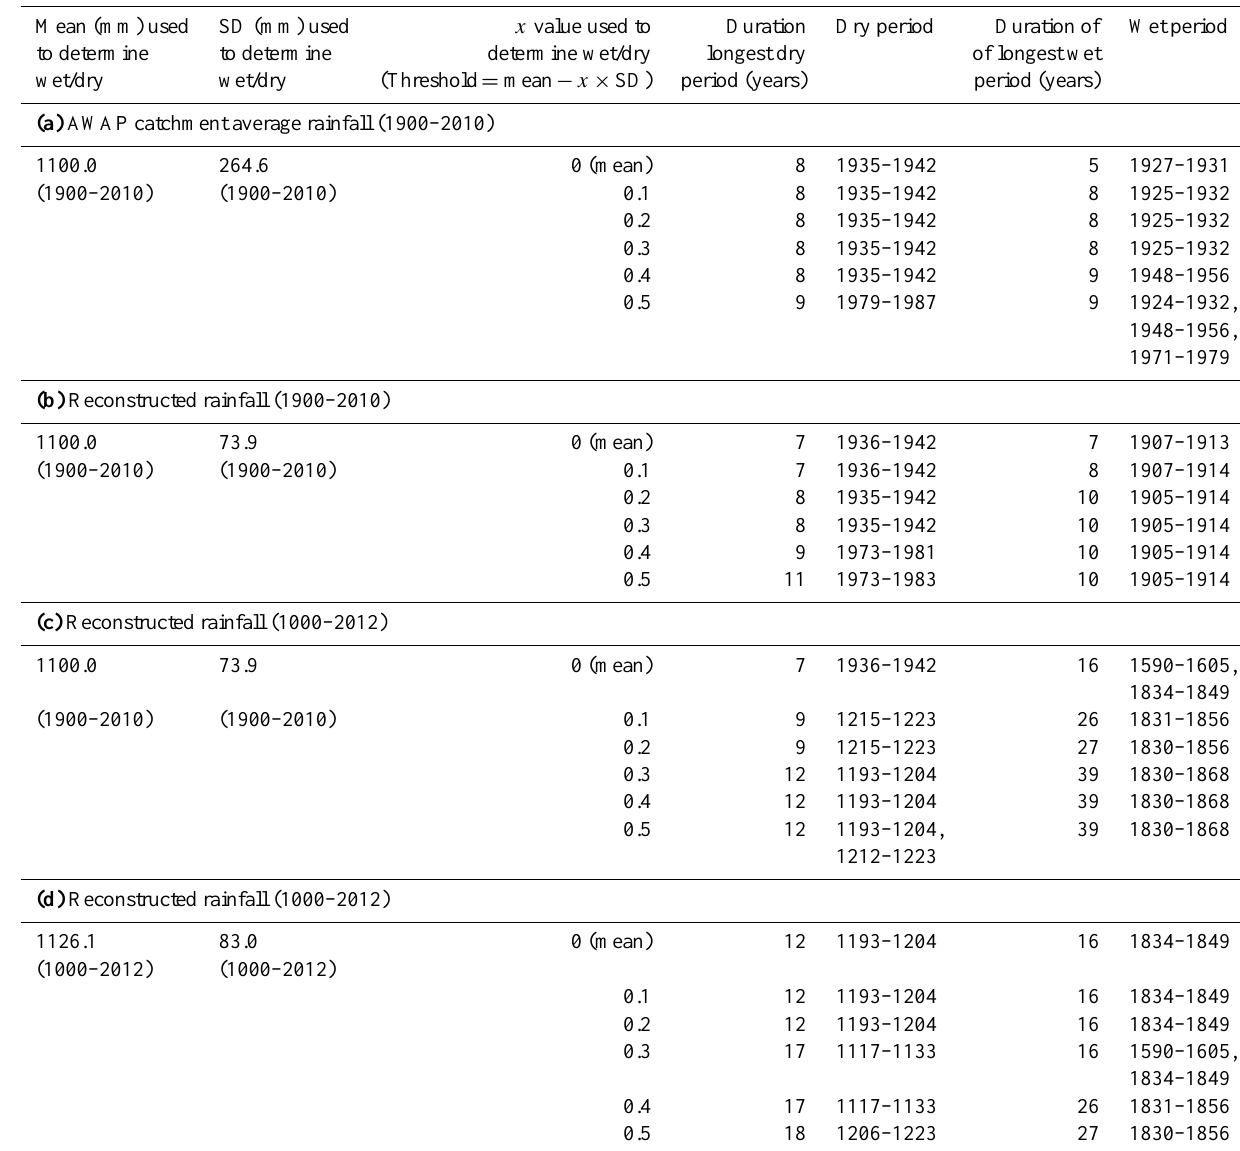
Table 3. Duration of longest dry and wet periods for the AWAP and reconstructed rainfall. Mean (mm) used SD (mm) used x value used to Duration Dry period Duration of Wet period to determine to determine determine wet/dry longest dry of longest wet wet/dry wet/dry (Threshold = mean − x × SD) period (years) period